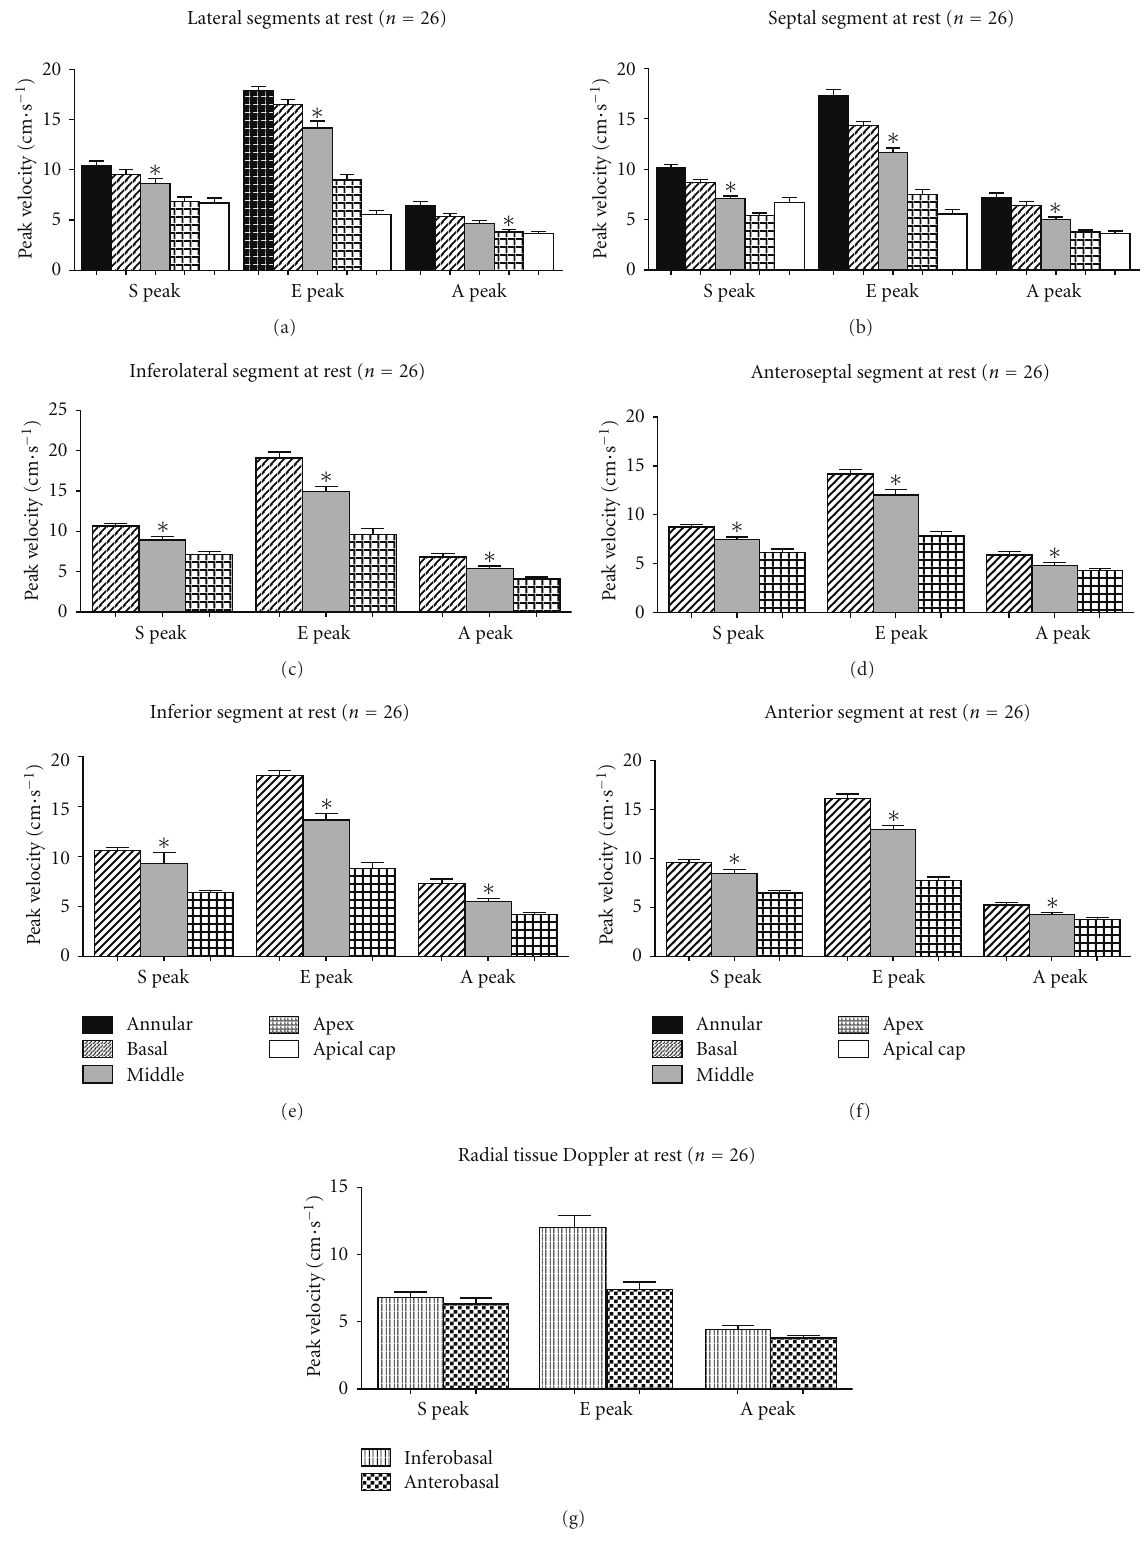
Figure 2: Resting Tissue Doppler velocities for each ventricular wall ((a)–(f))and for radial measurements of the inferobasal and anterobasal segments (g). S: systolic velocity; E: early diastolic velocity; A: late diastolic velocity; Error bars are standard error of the mean. ∗ P < . 001. P values are determined for the comparison of values from basal to apical segments using repeated measures ANOVA for within subject di ff erence with Greenhouse-Geisser